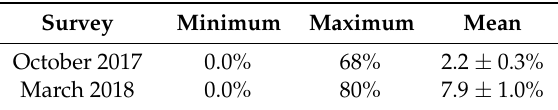
Figure 9. Regional application of automated MLi-20 cobble mapping in southern California for October 2017 and March 2018. ( a ) Beach area normalized by 50 m alongshore interval (beach width), ( b ) cobble area normalized by 50 m alongshore interval, and ( c ) cobble density. Beach width was measured from MHW to the back beach line. Table 4. Regional cobble density comparison between October 2017 and March 2018. Mean values consider the mapping error (<12%, best fit line, Figure 8).